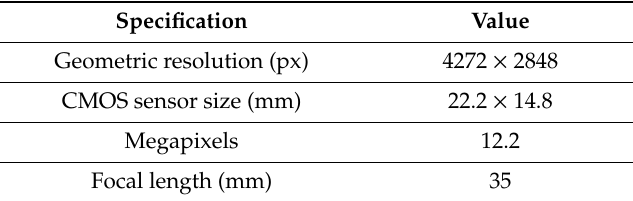
Table A1. Main Parameters of RGB Camera (Canon EOS 450D).